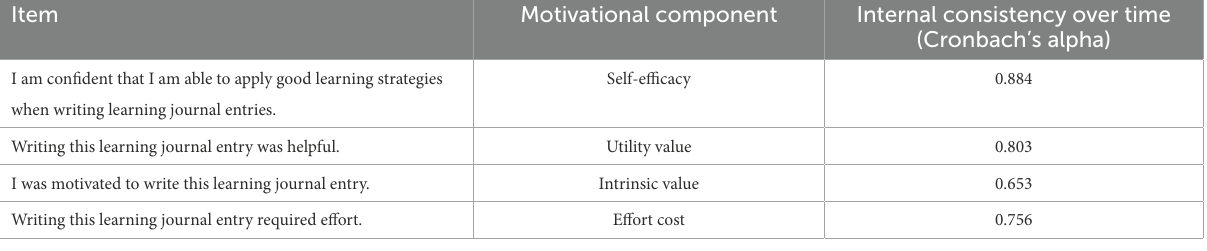
TABLE 3 Self-rating items answered after every learning journal.